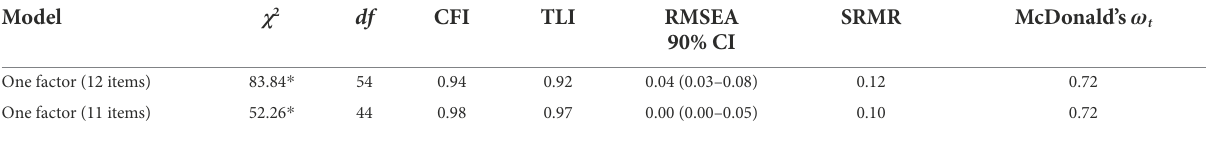
TABLE 4 Summary of fit indices of the Bangla Rotter’s I-E scale ( N = 178). Model